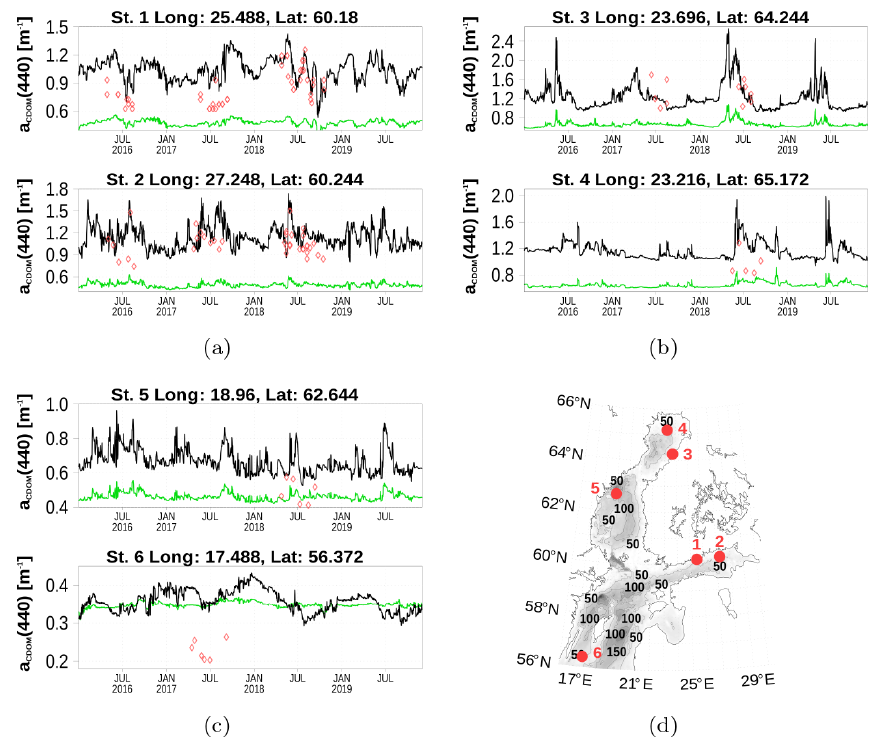
Figure 6. Surface a CDOM ( 440 ) time series at six stations. Location of the stations is shown in (d) . Absorption estimates based on simulated CDOM are shown in black, based on a conversion from simulated salinity in green, and red diamonds are observations. The map was created using the software package GrADS 2.1.1.b0 (http://cola.gmu.edu/grads/, last access: 6 August 2021), using published bathymetry data (Seifert et al.,